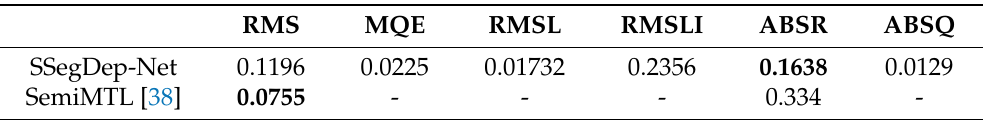
Figure 22. Results from the SSegDep-Net model on the Cityscapes dataset. Table 6. Quantitative results using the RMS, MQE, RMSL, RMSLSI, ABSR, and ABSQ error metrics (see the Appendix A). Lower values are